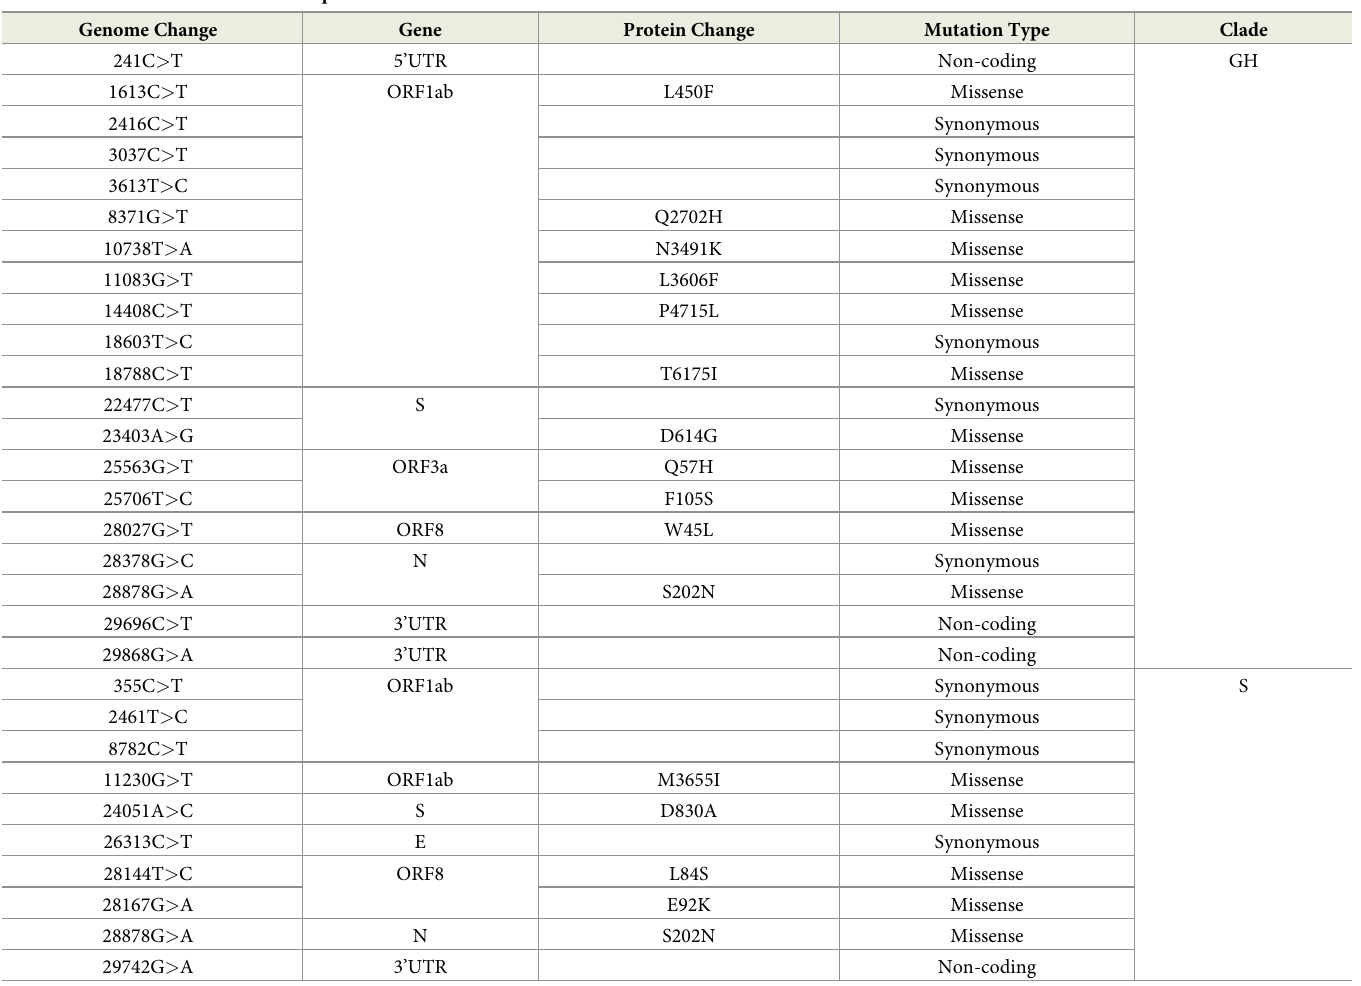
Table 3. Mutations in SARS-CoV-2 sequences of